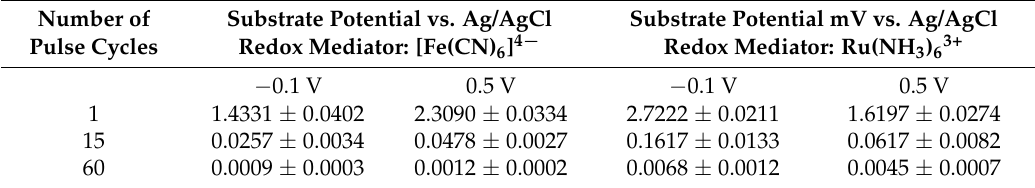
Table 1. Dimensionless rate constant κ in dependence of substrate potential and redox species.